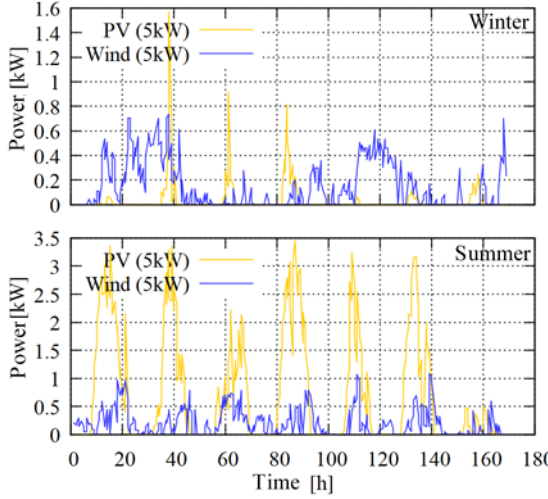
Figure 11. PV and wind power (normalized to 5kW).